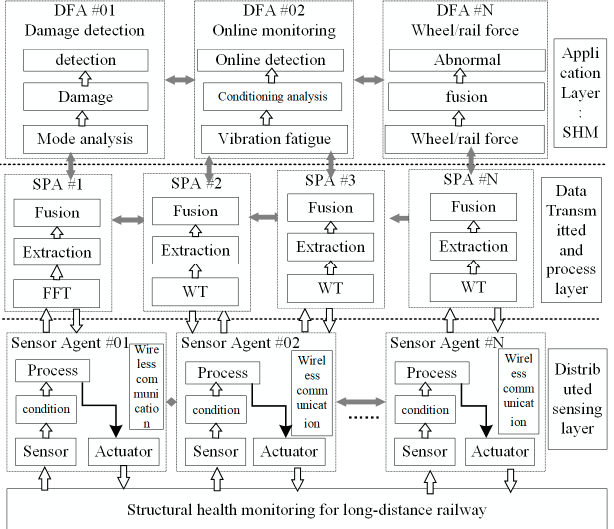
Figure 2. The monitoring architecture of large-scale rail structure based on MAS.